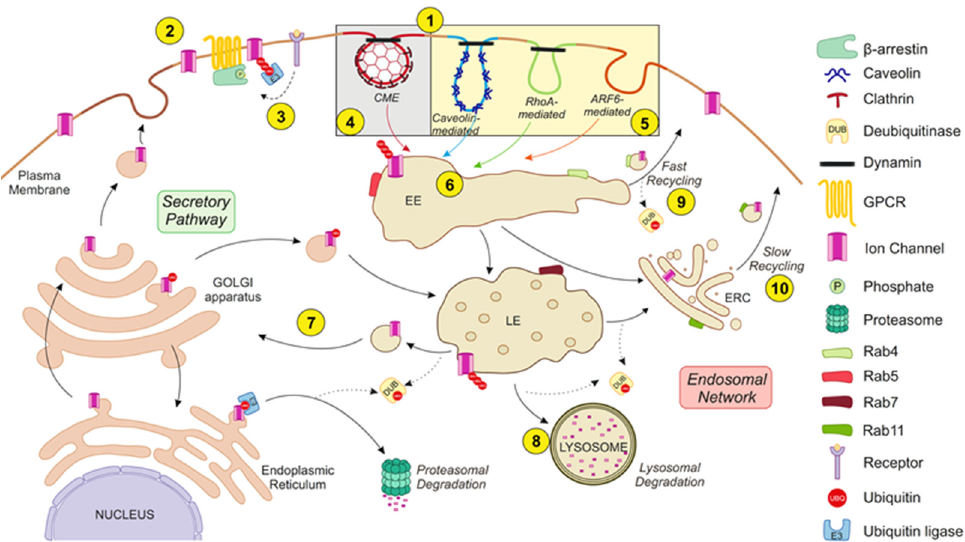
Figure 2. The endocytic ICh network. The balance between the secretory pathway and the endosomal network regulates ICh abundance at the plasma membrane. The endocytic network starts with the internalization of protein cargo by distinct mechanisms ( 1 ). ICh exhibits constitutive turnover but undergoes massive internalization upon specific stimulation. Thus, receptor activation (e.g., GPCR activation) provides a platform by which β -arrestins associate with receptors and ICh to mediate channel endocytosis ( 2 ). Receptor stimulation also triggers posttranslational modifications of IChs, such as phosphorylation (P) and ubiquitination (UBQ), which is realized through specific kinases and ubiquitin ligases (E3), respectively, which induce ICh endocytosis ( 3 ). Di ff erent internalization routes for IChs can be classified by their dependence on clathrin in (i) clathrin-mediated endocytosis (CME) ( 4 ) or (ii) clathrin-independent endocytosis (CIE) ( 5 ). CME is the most common internalization pathway for IChs. CIE mechanisms can be classified as caveolin-, RhoA- or ARF6-mediated. Internalized vesicles fuse to early endosomes (EEs) and are partially sorted ( 6 ). Target channels can be recycled (either back to the plasma membrane or to the secretory pathway) ( 7 ) or degraded in lysosomes ( 8 ). Recycling to the plasma membrane is achieved through tubule-vesicular transport carriers, known as the “fast recycling” process ( 9 ), or by the endocytic recycling compartment (ERC), known as the “slow recycling” process ( 10 ). Moreover, vesicles can bypass the trans-Golgi network and enter the secretory pathway ( 7 ). Therefore, there is an interplay between E3 ligases and deubiquitinating (DUB) enzymes. Ubiquitin is released from ubiquitinated substrates by DUBs. IChs sorted for degradation continue to move through the endocytic pathway from the EEs to the late